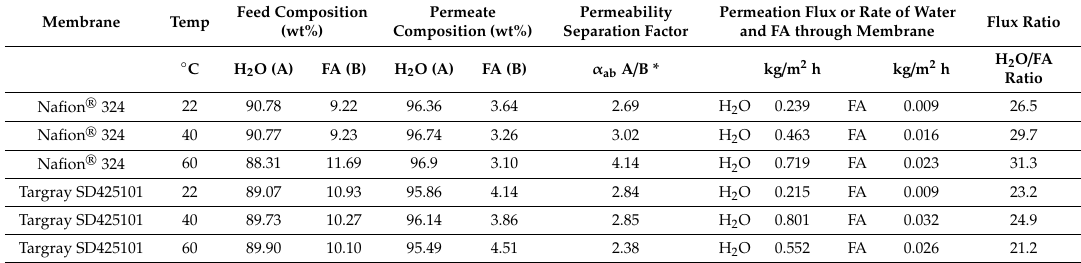
Table 2. Experimental pervaporation permeation flux data comparison between Nafion ® N324 and Targray SD425101 membranes for both water and formic acid at a 10 wt% FA feed